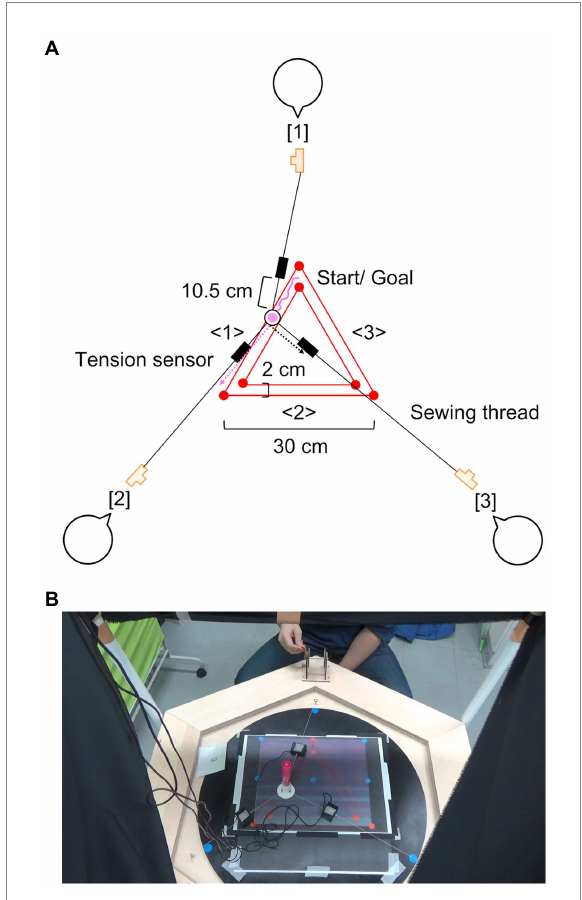
FIGURE 1 Coordinated drawing task. (A) Represents the pattern diagram when drawing side <1>. The length and width of each triangle’s side are 30 cm and 2 cm, respectively. Then, if operator [3] in the adjusting role does not generate any tension, the pen greatly deviates from the outside, shown by the dotted magenta arrow. Conversely, if the operator pulls the pen excessively, it greatly deviates from the inside, shown by the dotted black arrow. (B) Represents the experimental image. It was recorded from a bird’s-eye view using a video camera. The origin source of this figure refers to our proceedings paper (Ichikawa and Fujii, 2021).